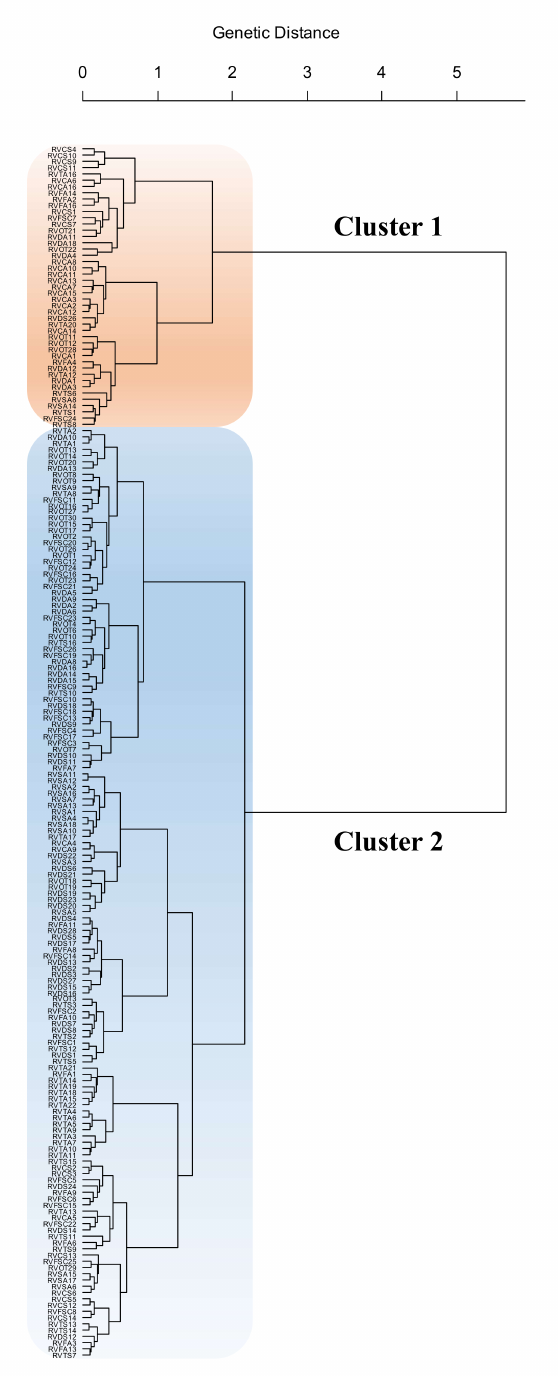
Figure 6. Ward’s hierarchical cluster analysis based on the standardized mean Euclidean distance for agronomic, physicochemical, and bioactive compound traits that were obtained from di ff erent Fragaria × ananassa Duschesne ex Rozier